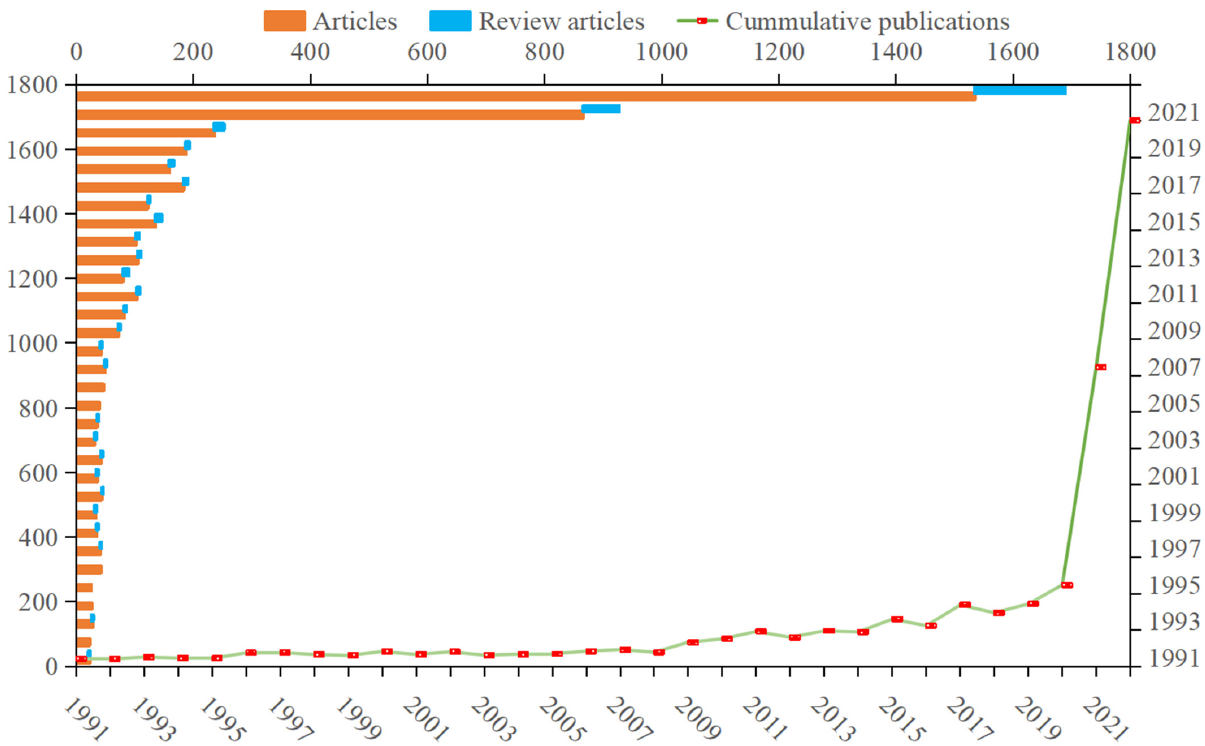
Figure 2. Annual time trends in publications on carbon neutrality.